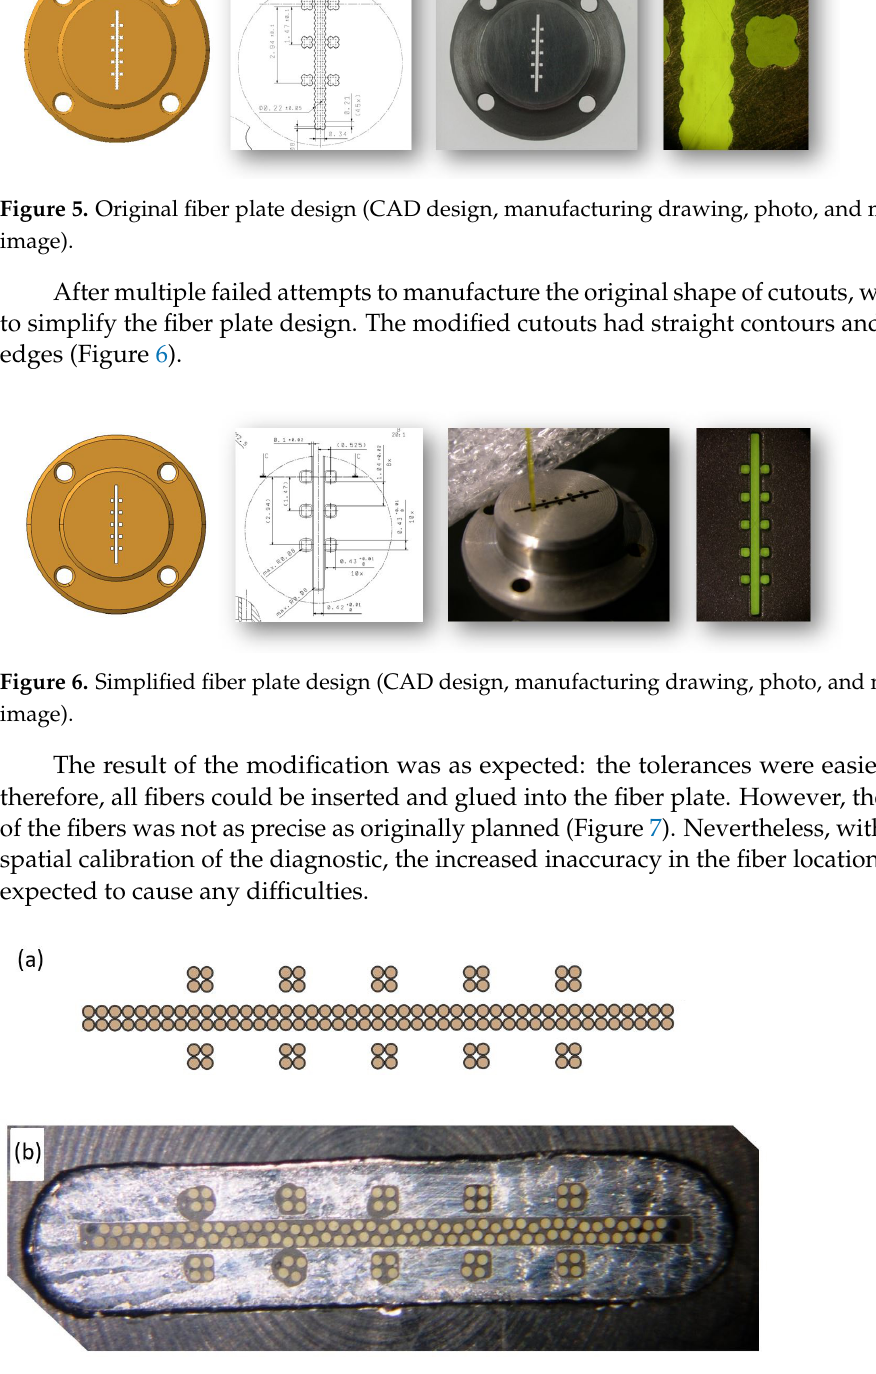
Figure 7. Fiber arrangement—theoretical ( a ) and result ( b